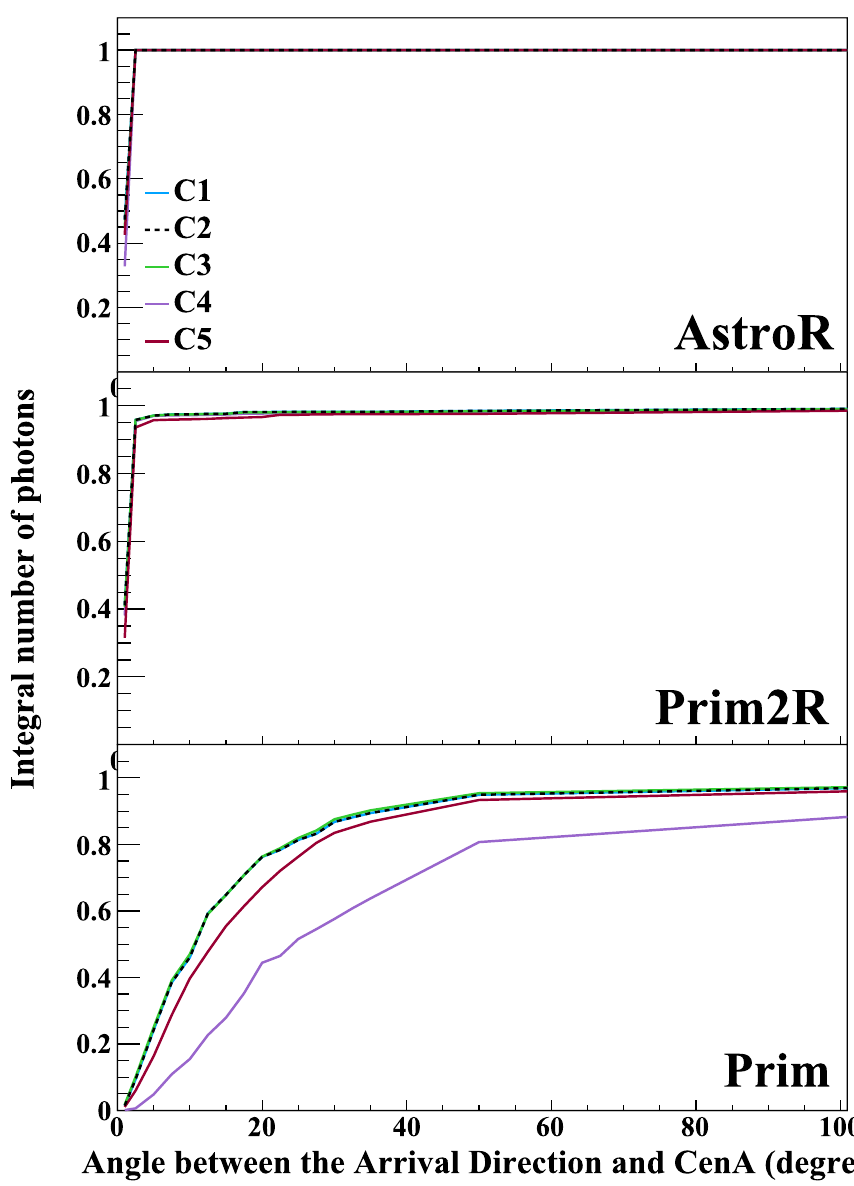
Fig. 11 Integral distribution of the angular distance between Cen A and the arrival direction of secondary photons with E < 10 17 eV. Three EGMF are shown: AstroR, Prim2R and Prim. Each curve corresponds to a composition abundance: